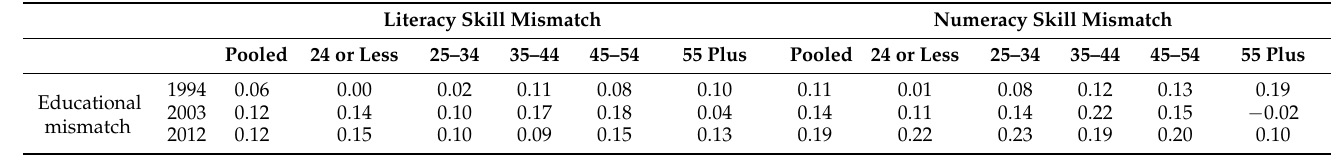
Table 1. Correlation between educational and skill mismatch by age group.